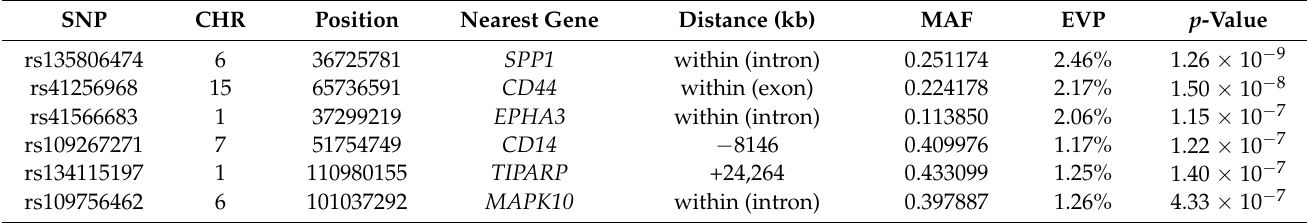
Table 3. Details on the detected significant SNPs and their closest genes.